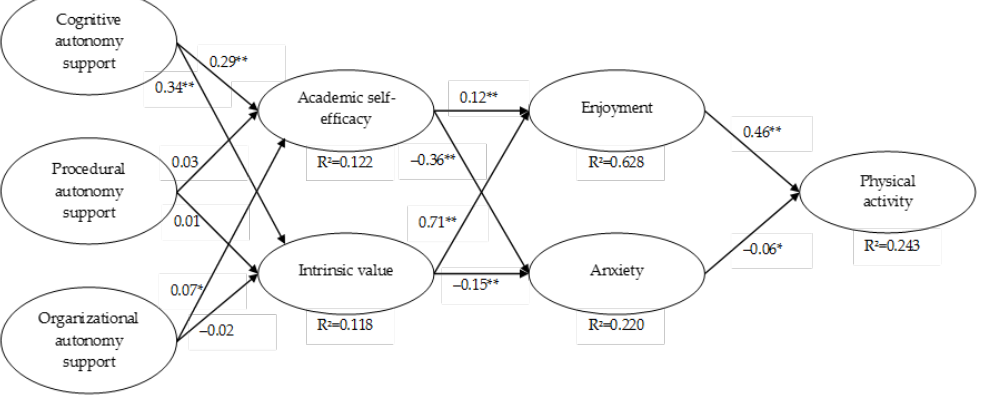
Figure 2. Standardized path coefficients for the variance-based structural equation model. * = p < 0.05, ** = p <